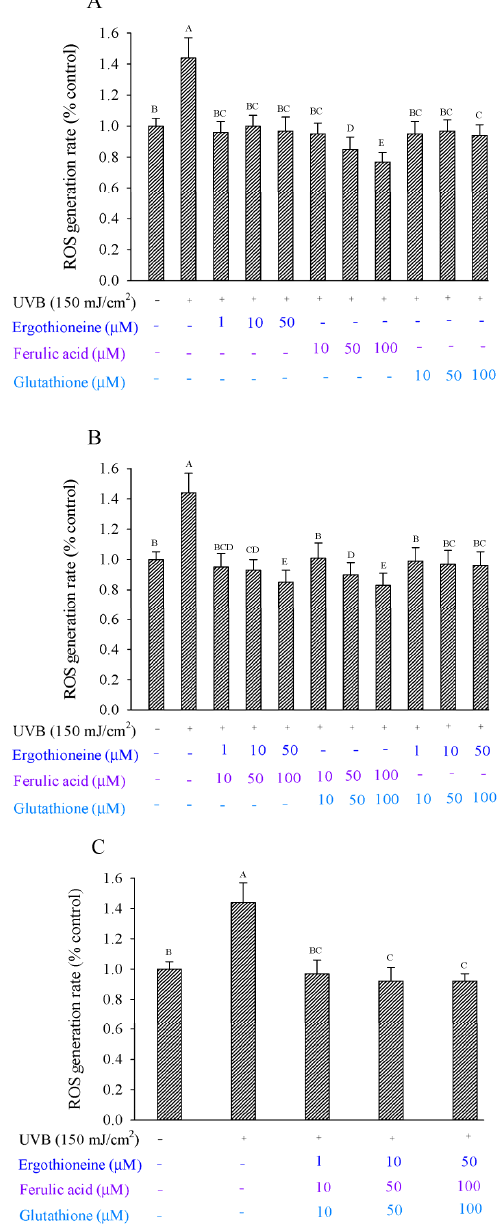
Figure 5. ROS production in Hs68 cells induced by UVB irradiation in the presence of a single ( A ), combination of two ( B ), or combination of three types of antioxidants ( C ), namely ergothioneine, ferulic acid, and glutathione. Each value is expressed as the mean ± SD ( n ≥ 3). Different letters indicate significant differences among treatments ( p < 0.05).